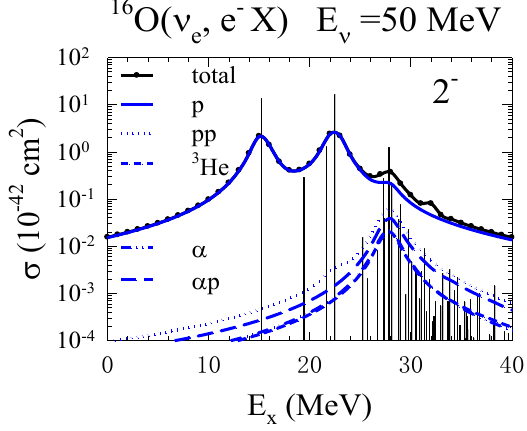
Fig. 2. Calculated total cross sections for 16 O (ν e , e － ) 16 F obtained by shell-model calculations with the SFO-tls and SFO as well as CRPA calculation [21]. (Taken from Ref. [18])